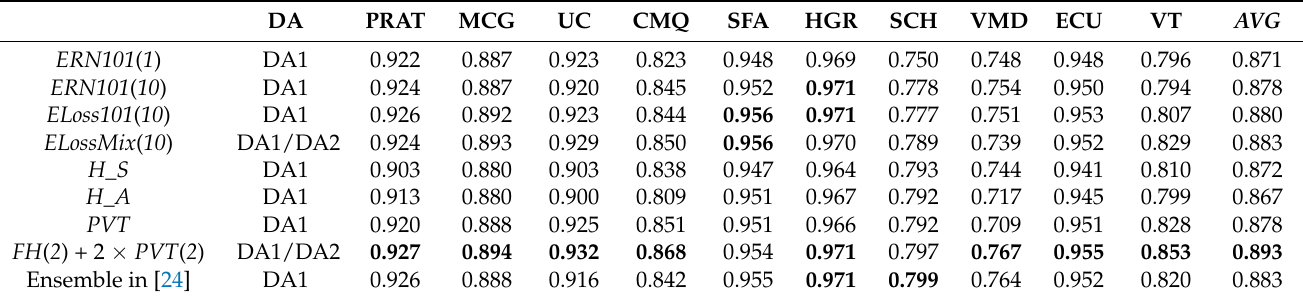
Table 6. Performance (dice = F1-score) in the skin detection problem. Best performance is marked in bold